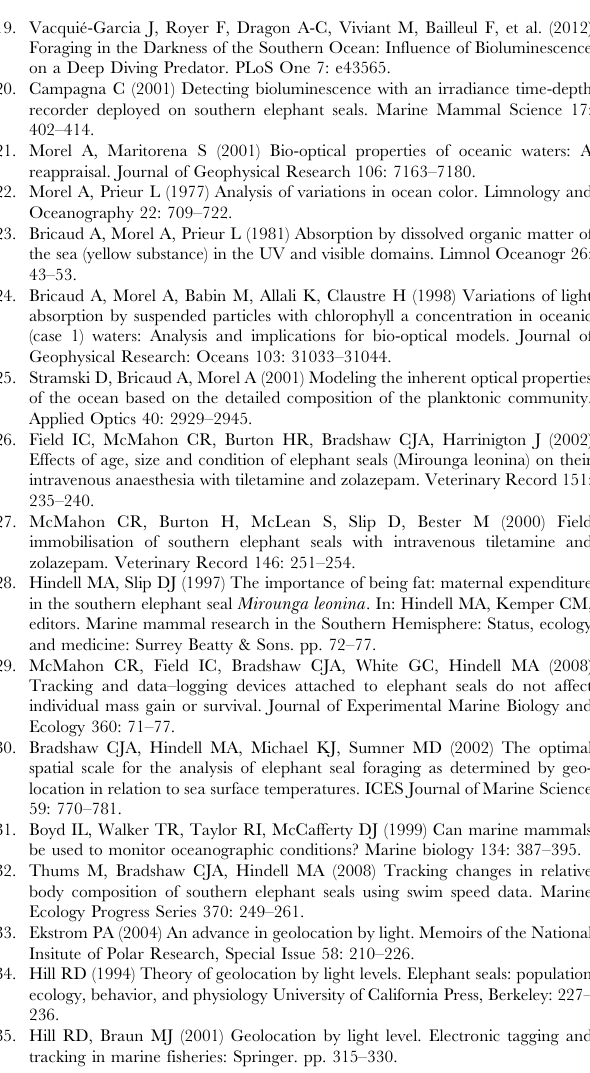
Figure S1 The relationship between relative light level and blue light intensity (W cm 2 2 ) for a typical tag. Calibrations are checked by Wildlife Computers at levels 10 2 5 , 10 2 7 and 10 2 9 W cm 2 2 , which correlates to light level values around 150, 110 and 70 respectively. Furthermore, these light level values roughly equate to specific daylight conditions ranging from full sunlight to overcast night. Source: Wildlife Computers, USA. (TIF) Figure S2 Locations of each annual deployment cohort. Each location is assigned to one of three frontal zones: Polar Frontal Zone (PFZ – orange); north of the southern Antarctic Circumpolar Current (SACCF-N - green); south of the Southern Antarctic Circumpolar Current Front (SACCF-S - blue). Maps show the bottom of Tasmania (Tas) and New Zealand (NZ, top)